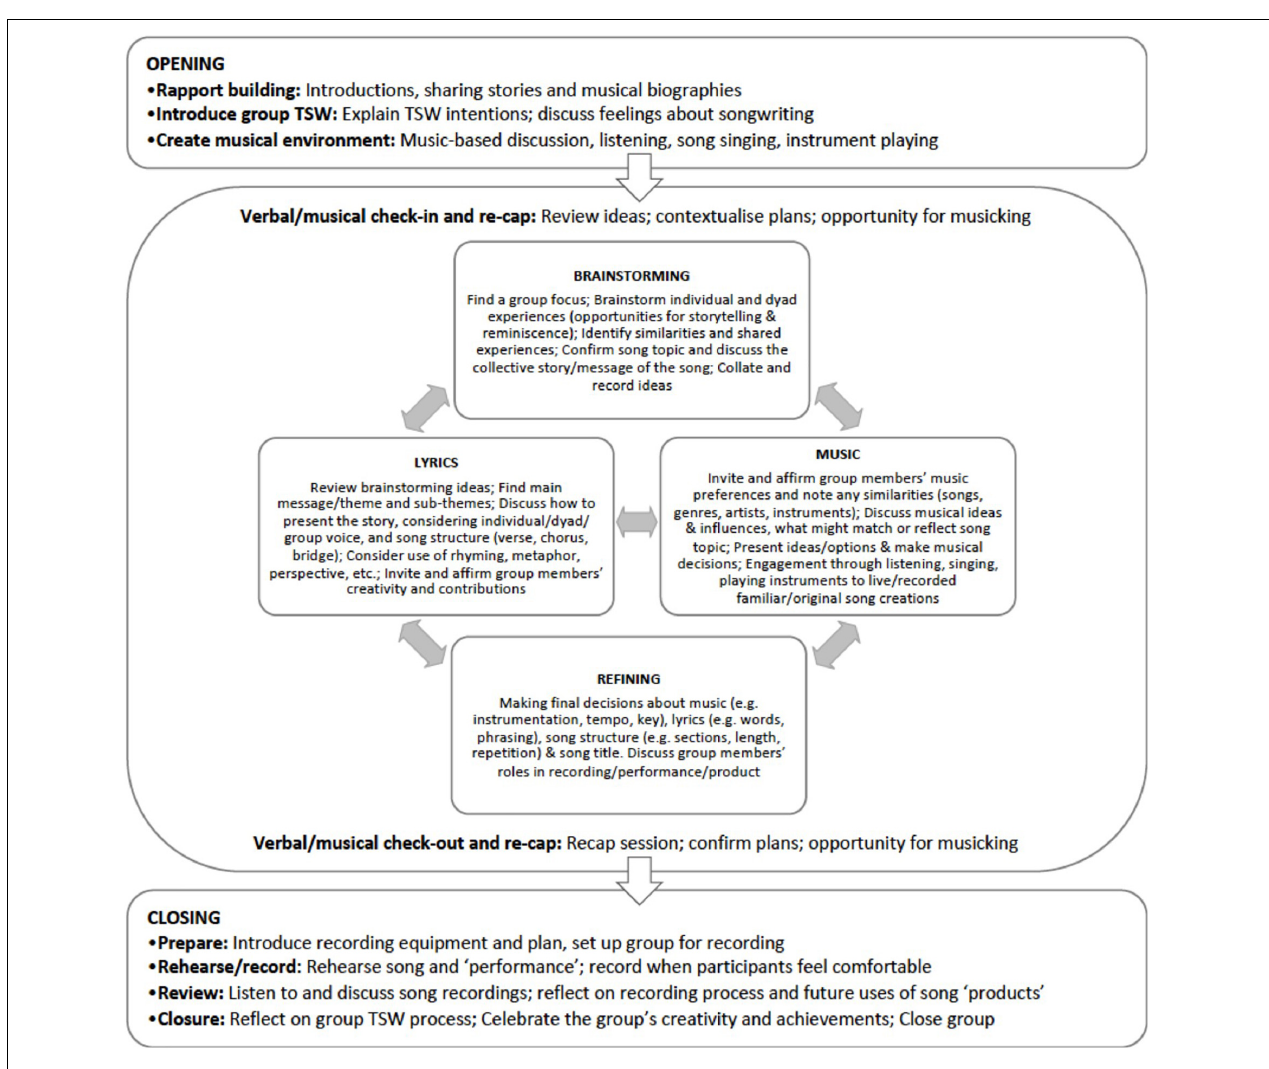
FIGURE 2 | Session